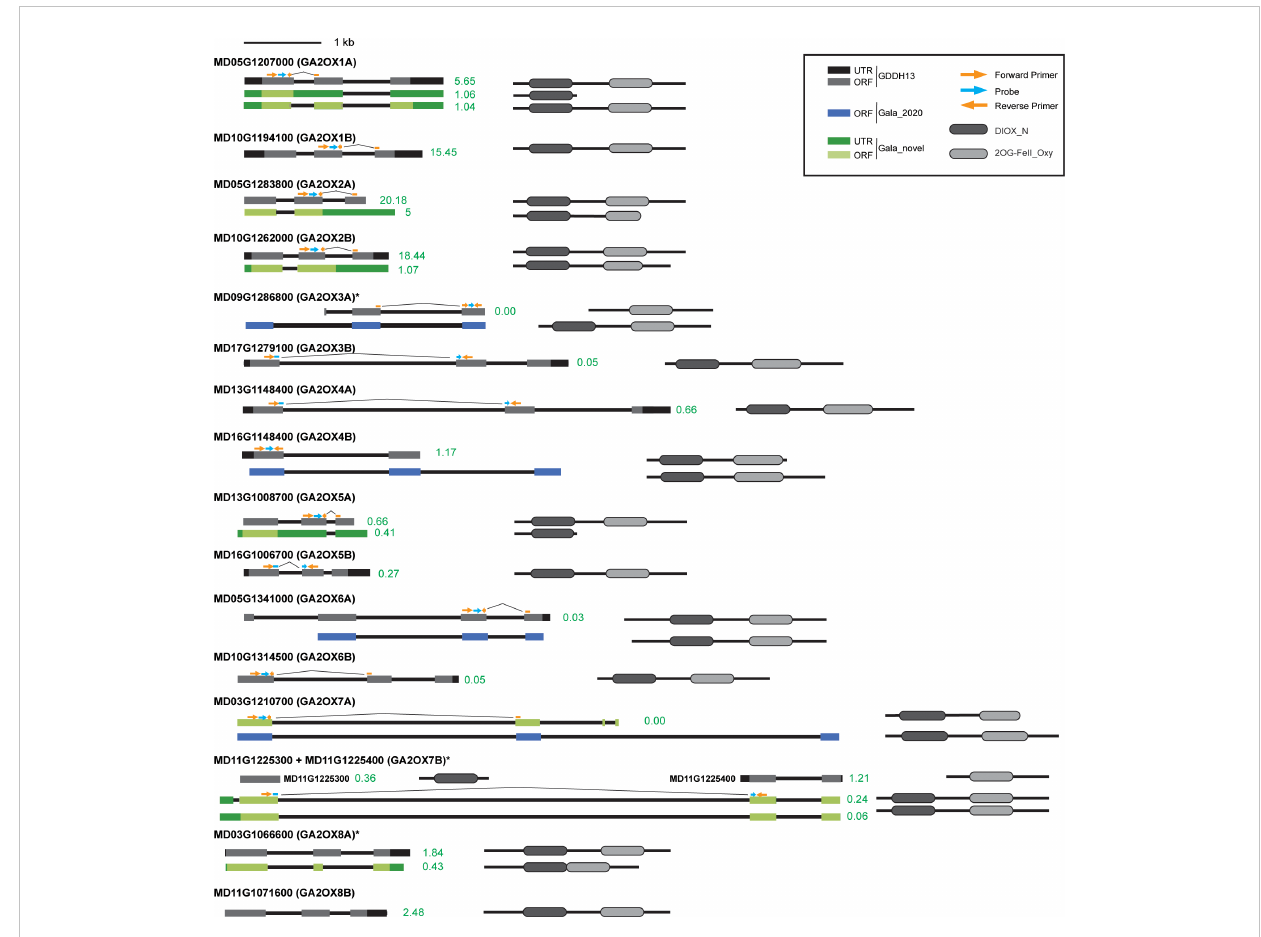
FIGURE 2 MdGA2ox gene, transcript, and protein models. Primary gene models as annotated for the GDDH13 genome are shown at left in black/gray. The gene models annotated in the ‘ Gala ’ genome are mostly consistent with the ‘ GDDH13 ’ genome, except for four loci ( MdGA2ox3A , -4B , -6A and -7A ) where ‘ Gala ’ models are depicted in blue. Additional transcript models from ‘ Gala ’ based on our data are shown in green. Untranslated regions (UTRs) (black or dark green) and exons (gray, light green or blue) are indicated as boxes. A scale bar for transcript models is given at the top. Positions of Taqman primers (orange) and probes (light blue) are shown as arrows. Estimates of expression levels as FPKM (Fragments Per Kilobase of transcript per Million mapped reads) for each transcript in the ‘ Gala ’ shoot apex are shown in green next to the transcript